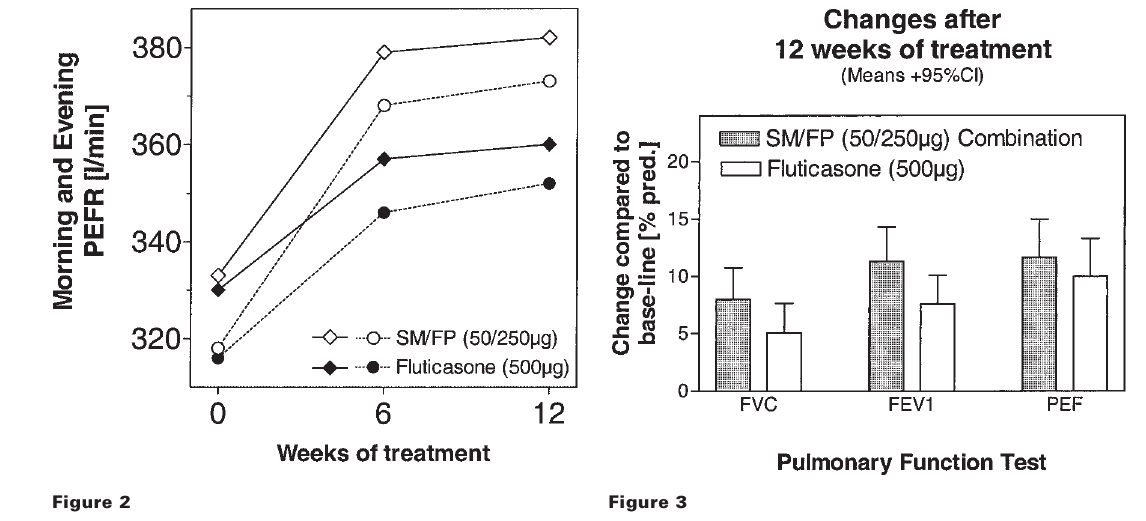
Figure 3 Spirometry results during treatment: Forced vital capacity, FVC, and forced expiratory volume in 1 second, FEV 1 , ex- pressed as percentages of the predicted value (means).